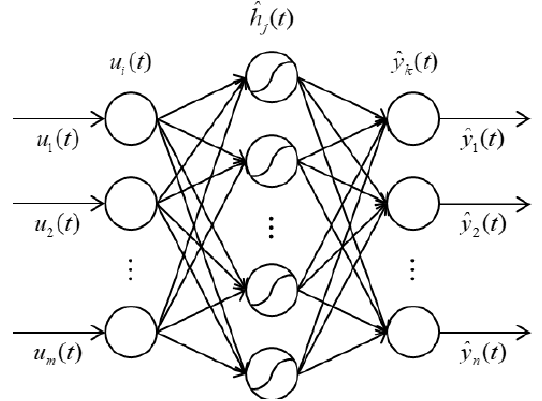
Figure 1. The considered SFCNN structure.